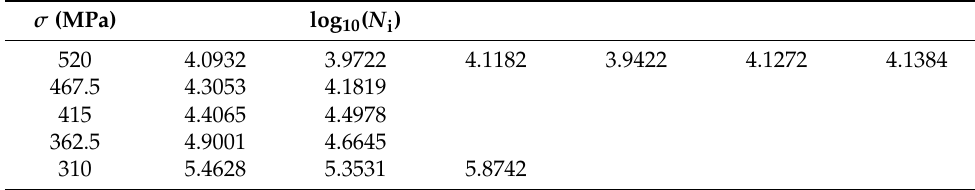
Table 3. Experimental results by tensile and compression testing.